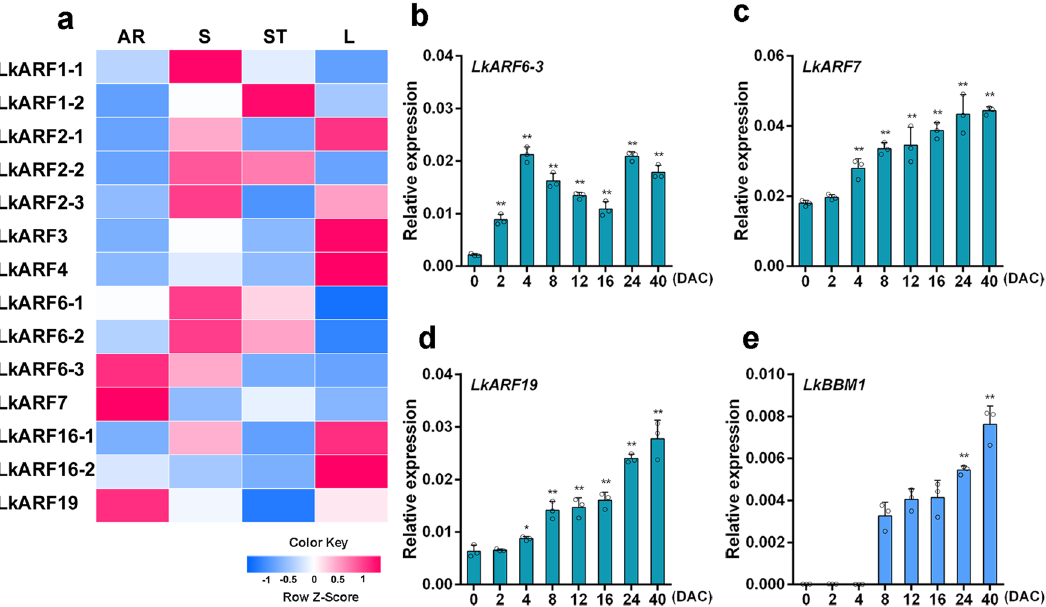
Fig. 1 Expression analysis of LkARF genes in larch. a Heat map of the expression of 14 LkARF genes in different tissues based on qRT-PCR. AR, adventitious roots; S, stems; ST, stem tips; L, leaves. The heat map was made using the Omiscshare tools (http://omicshare.com/tools/) with parameters as default. b – d qRT-PCR analysis of LkARF6-3 ( b ), LkARF7 ( c ), LkARF19 ( d ), and LkBBM1 ( e ) in the basal stem sections (0.5 cm) during in vitro propagation. DAC days after cutting. The LaEF1A gene was used as the internal control gene. The error bars represent standard deviations from three biological replicates; * P < 0.05 and ** P < 0.01, t test.